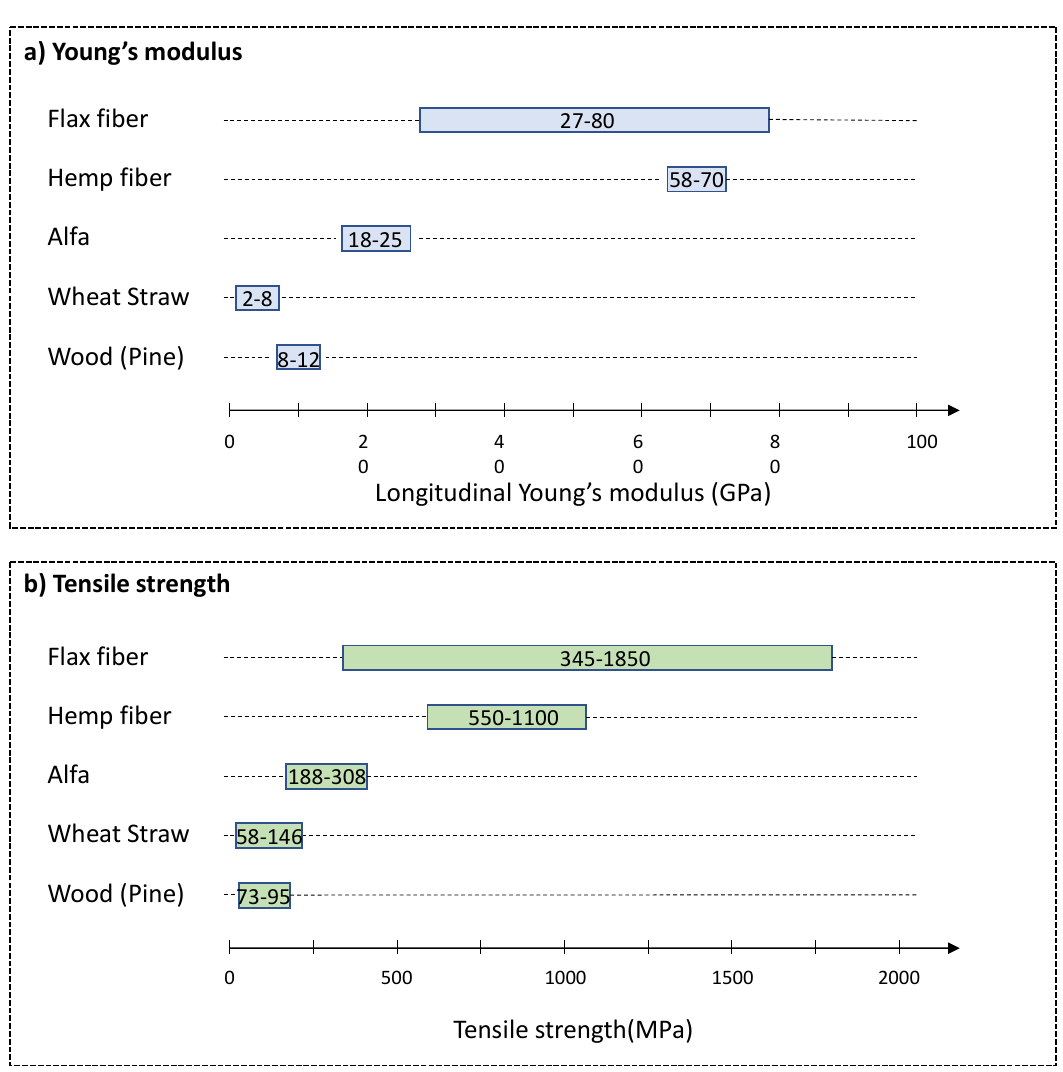
Figure 1. Main mechanical properties for different biomasses: ( a ) longitudinal Young’s modulus and ( b ) tensile strength according to [37,42].